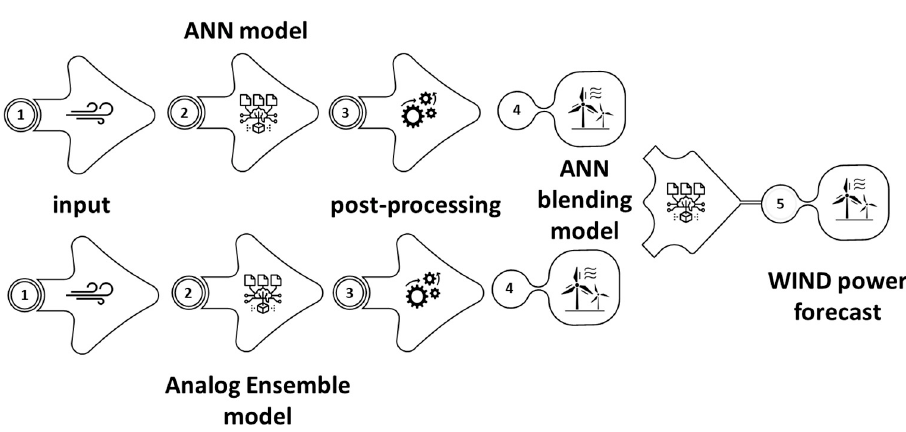
Figure 6. Diagram of the method used to predict the wind generation in each market zone.